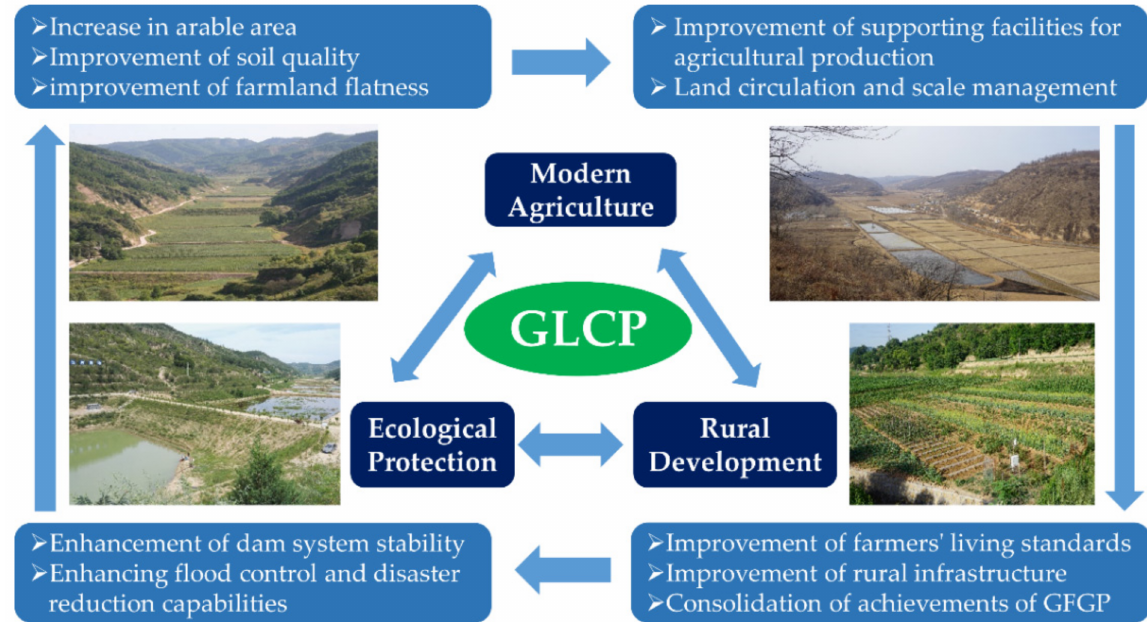
Figure 6. Comprehensive benefits of the GLCP to regional